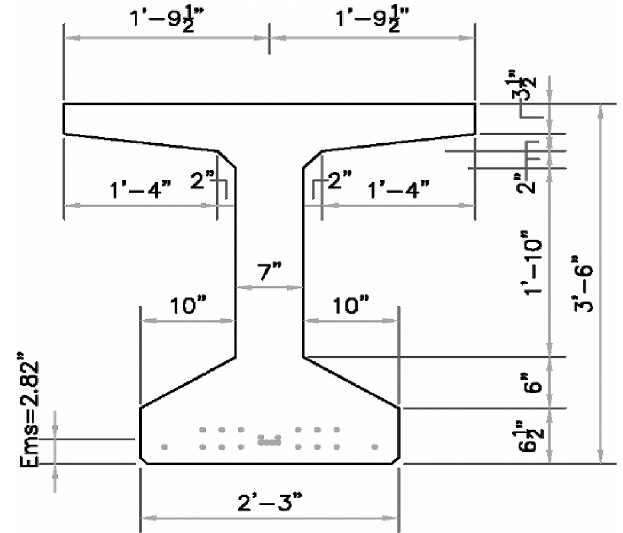
Fig. 1. Girder cross section at midspan.